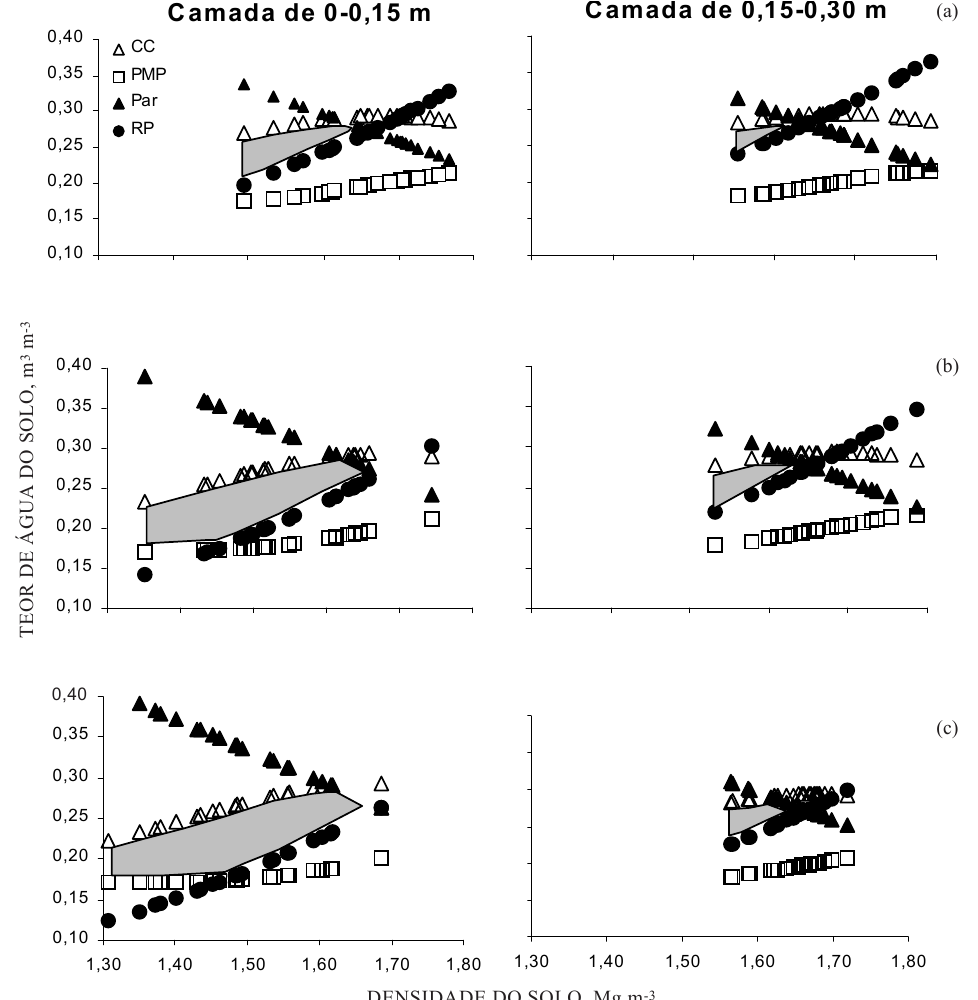
Figura 3. Teor de água no solo ( θθθθθ ) em função da Ds na capacidade de campo (CC), no ponto de murcha permanente (PMP), na porosidade de aeração de 10 % (Par) e na resistência do solo à penetração de 2,5 MPa (RP). A área hachurada representa o conjunto de IHOs correspondentes às densidades avaliadas para plantio sem revolvimento (a), preparo mínimo (b) e preparo convencional do solo